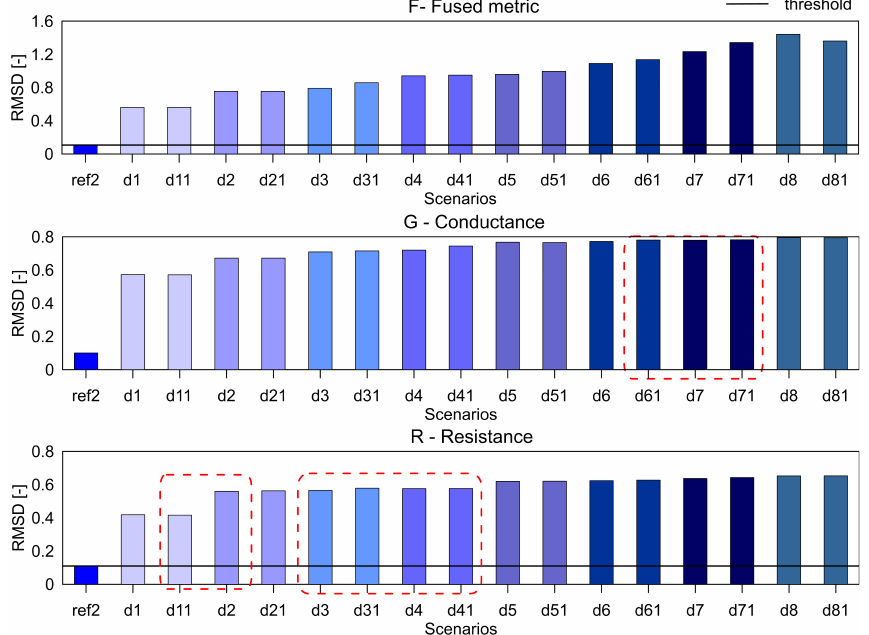
Figure 15. The RMSD index for the parameters F, G and R for aluminium plate over the frequency range 1 kHz to 1.3